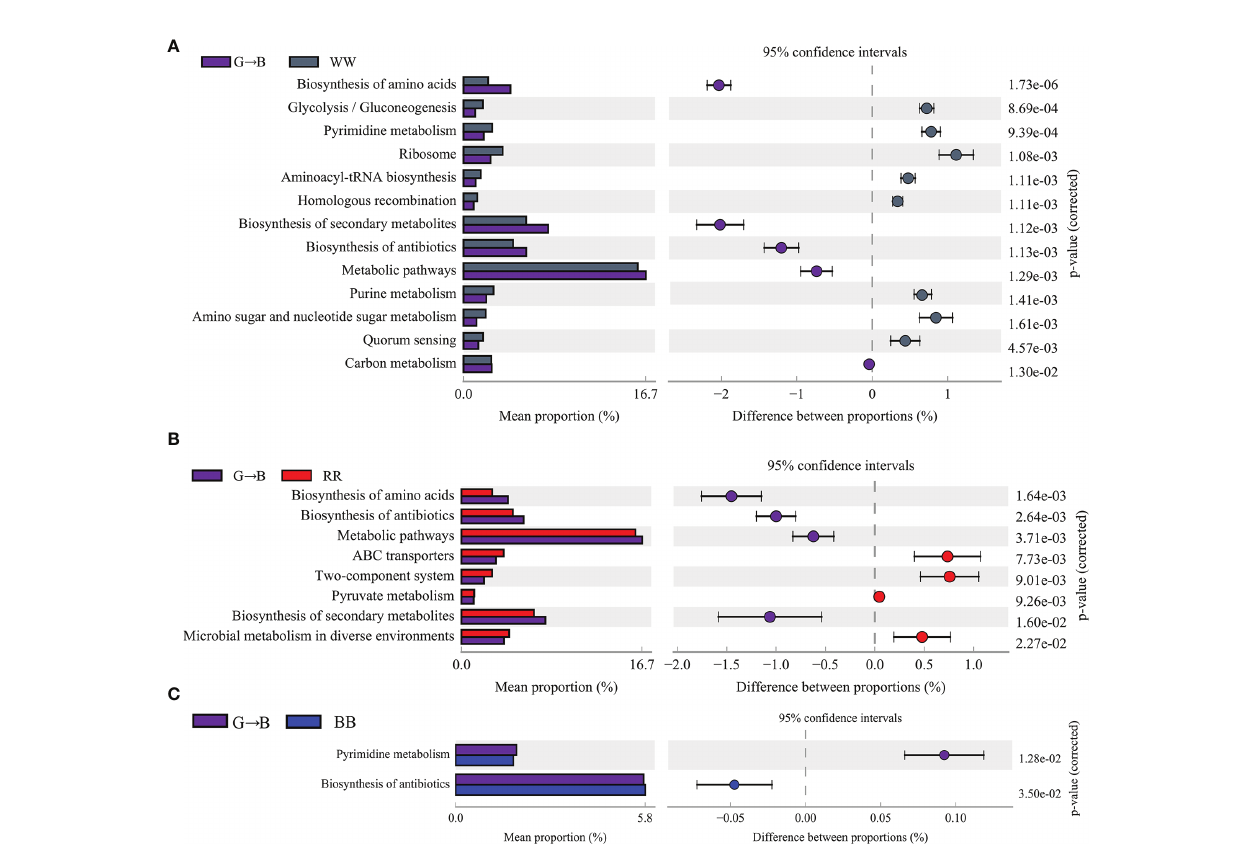
FIGURE 5 | Comparison of Kyoto Encyclopedia of Genes and Genomes pathway enrichment between the groups by statistical analysis of taxonomic and functional pro fi les at level 3. WW vs . G ! B (A) , RR vs . G ! B (B) , and BB vs . G ! B (C) . WW, white light; RR, red light; GG, green light; BB, blue light; G ! B, green light and blue light combination. The results are presented as means ± SEM. Different letters indicate signi fi cant differences between the treatments at the same age ( P < ( Figure 6U , P = 0.007 – 0.012), oxoglutaric acid ( Figure 6V , P = 0.006 – 0.027), D-sedoheptulose 7-phosphate ( Figure 6W , P = 0.003 – 0.007), and allysine ( Figure 6X , P = 0.001 – 0.023) in G ! B